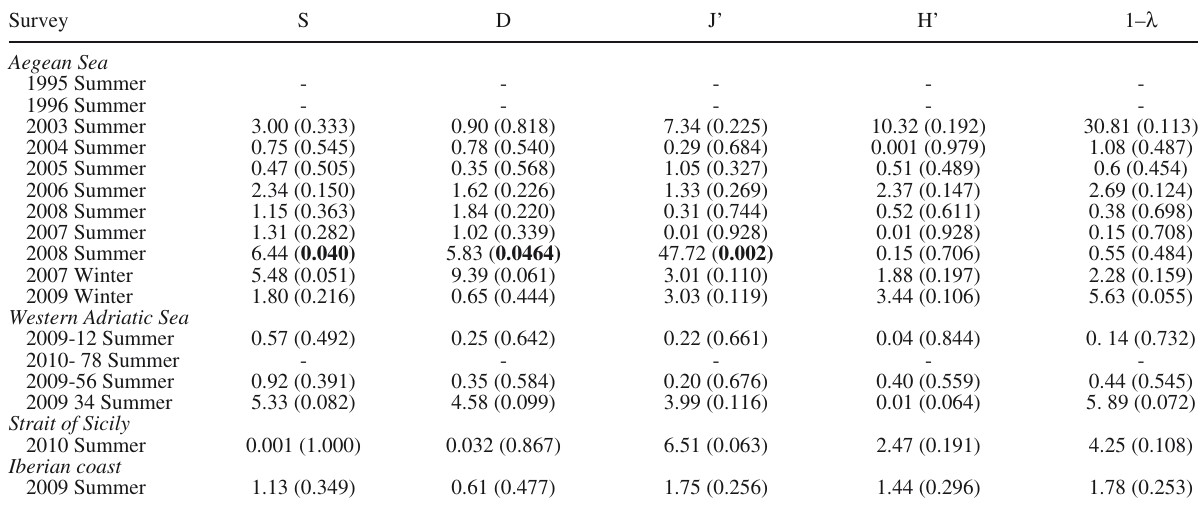
t able 4 . – ANOVA table for diversity indices estimated per survey (i.e. merged haul groups). For each index the test results and the p-value (in brackets) are presented. Significant probabilities are in bold. Empty cells represent surveys with only one species or those surveys where only anchovy and sardine were caught. S, number of species per haul; J, evenness index; H’, Shannon-Wiener diversity index; 1– λ , Simpson index.